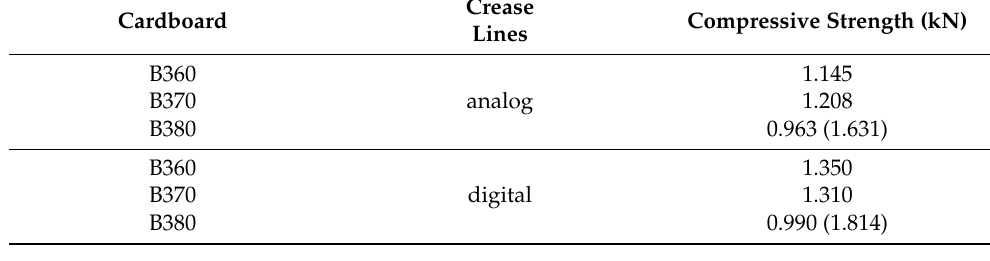
Table 5. The averaged results from box compression testing for different cardboards and production